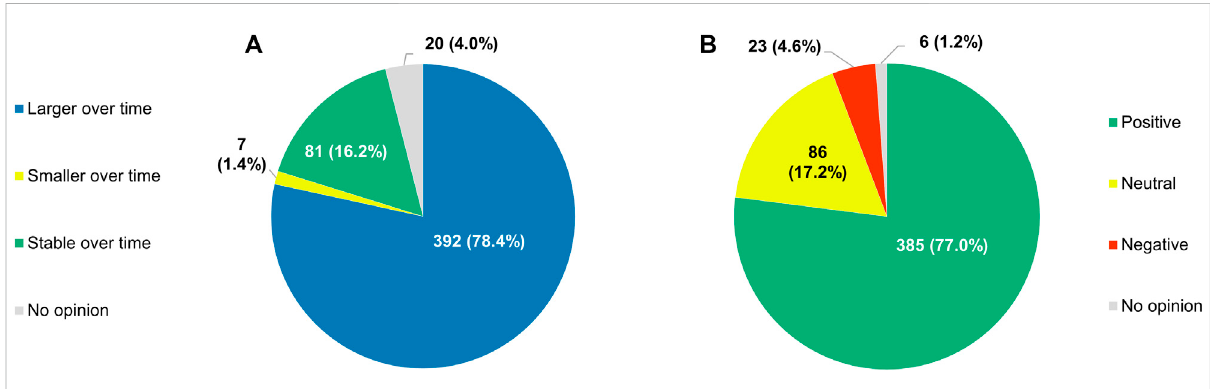
FIGURE 14 (A) Participants ’ projections of how the role of real-world evidence in the development of anticancer treatments will evolve over time, and (B) their perceptions of a hypothetical growth in its future in fl